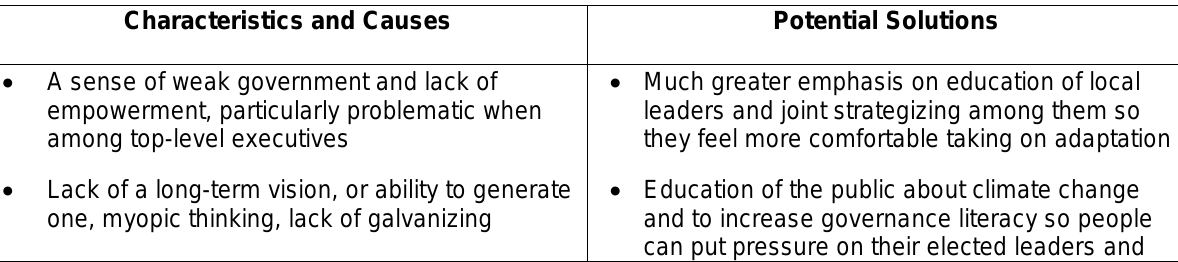
Table A2.2: Characteristics, Underlying Causes and Potential Solutions to